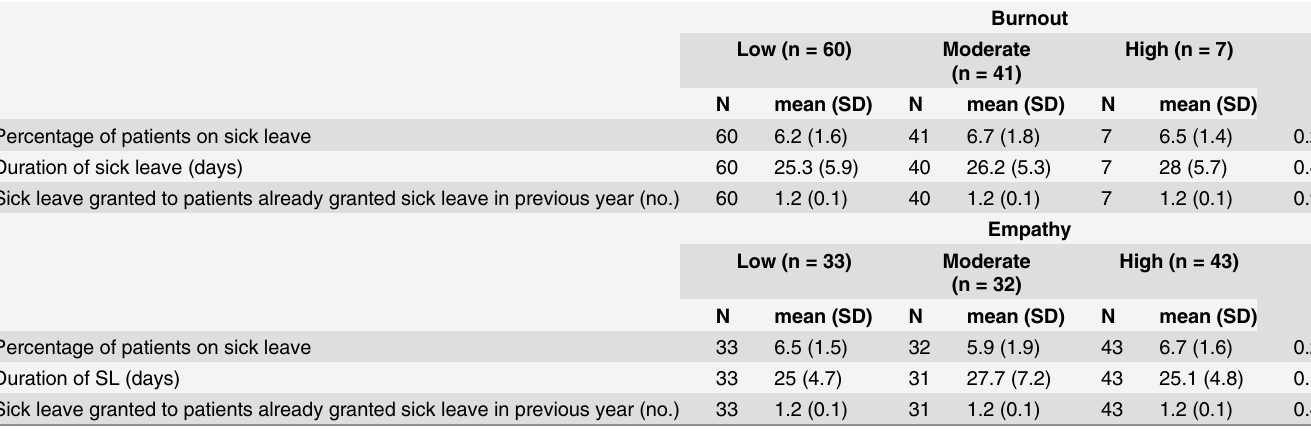
Table 2. Sick leave prescription according to empathy and